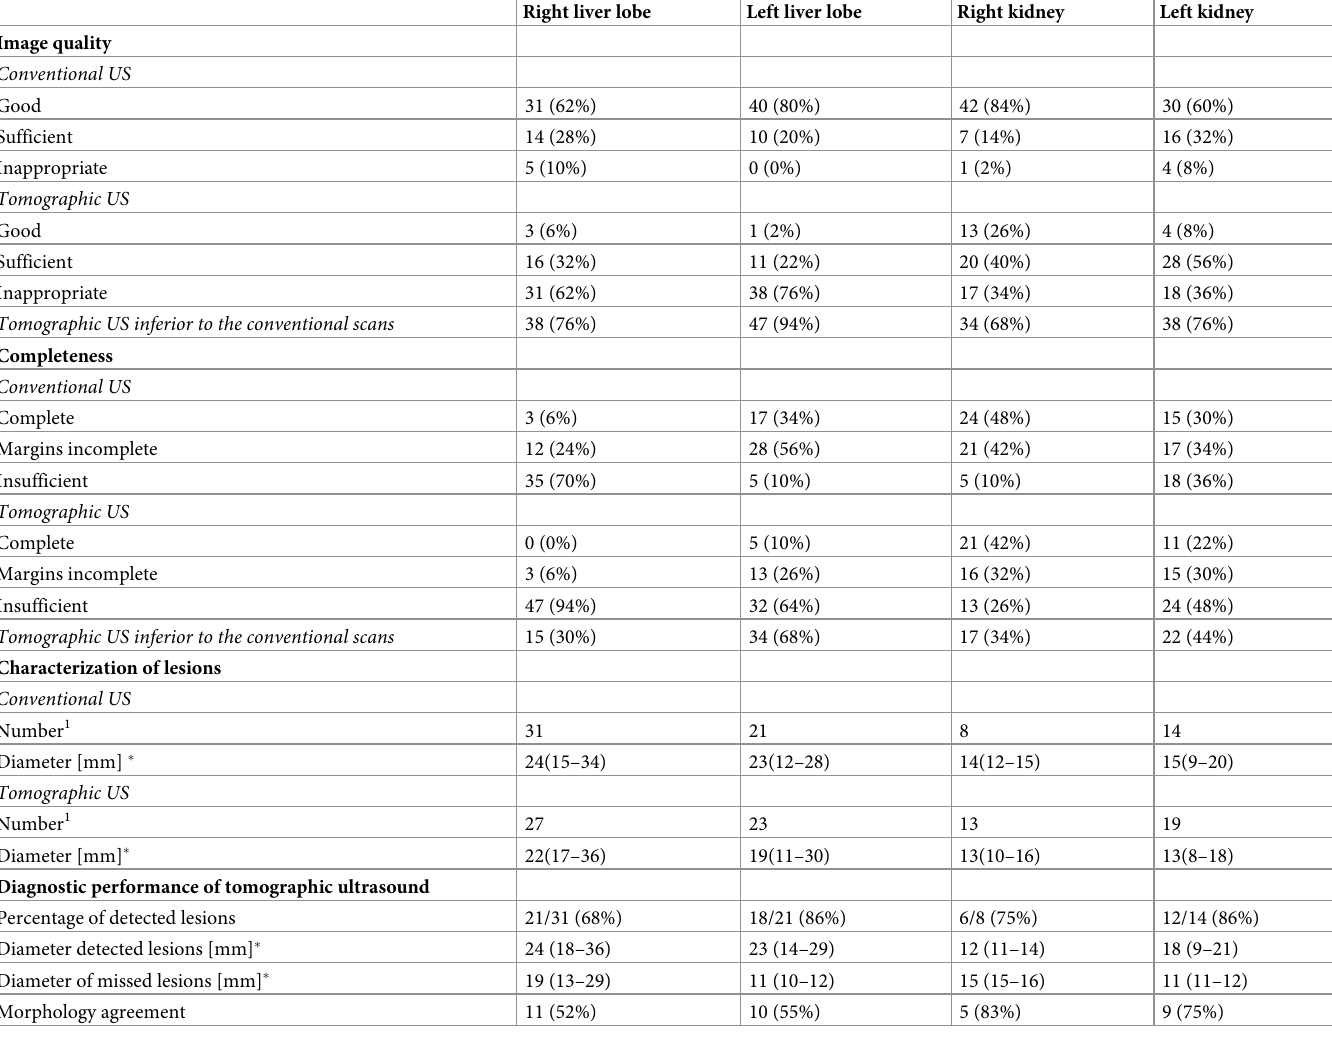
Table 2. Comparison of tomographic and conventional ultrasound in the patient cohort. Right liver lobe Left liver